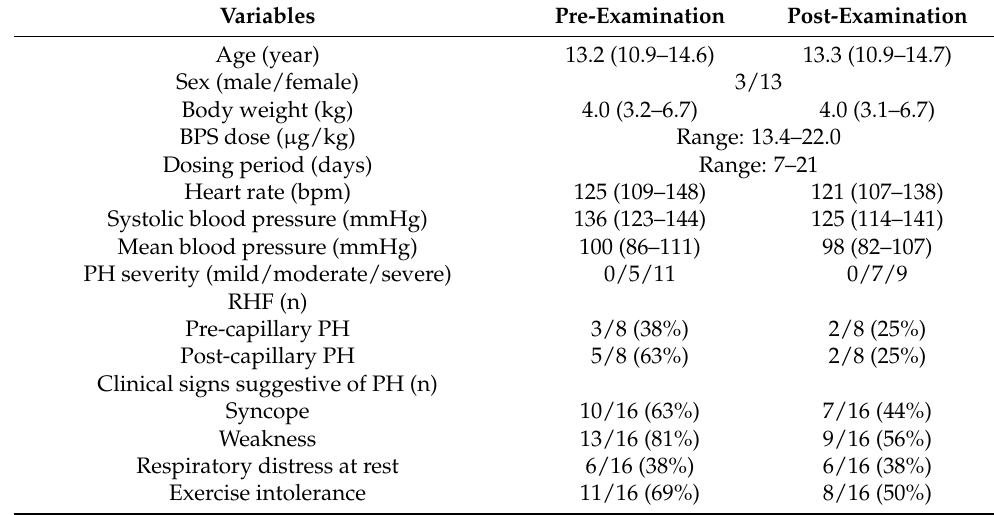
Table 1. Clinical characteristics of dogs with pulmonary hypertension before and after beraprost sodium administration.